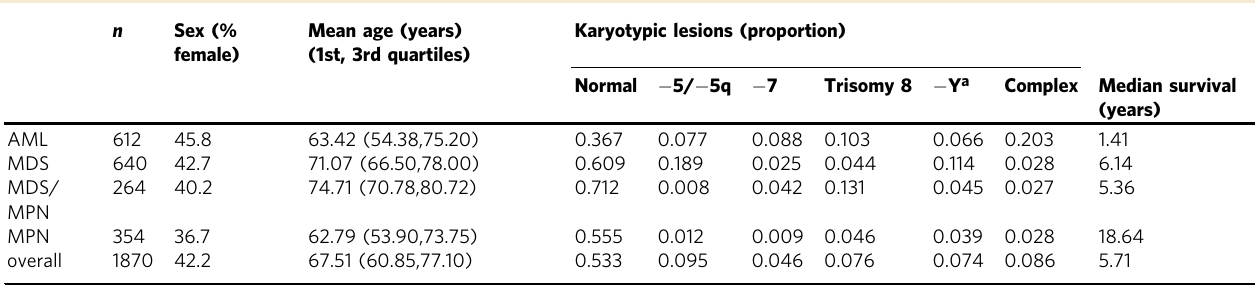
Table 1 Patient